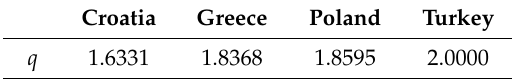
Table 8. Estimated (cid:1869) values of the log returns of the original series. Table 8. Estimated q values of the log returns of the original